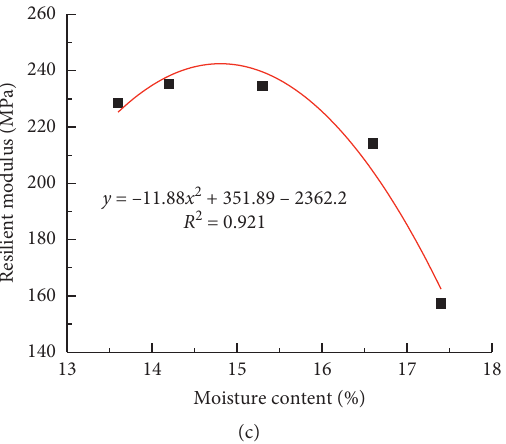
Figure 5: Relationship between resilient modulus and moisture content. (a) Gradation 1. (b) Gradation 2. (c) Gradation 3.